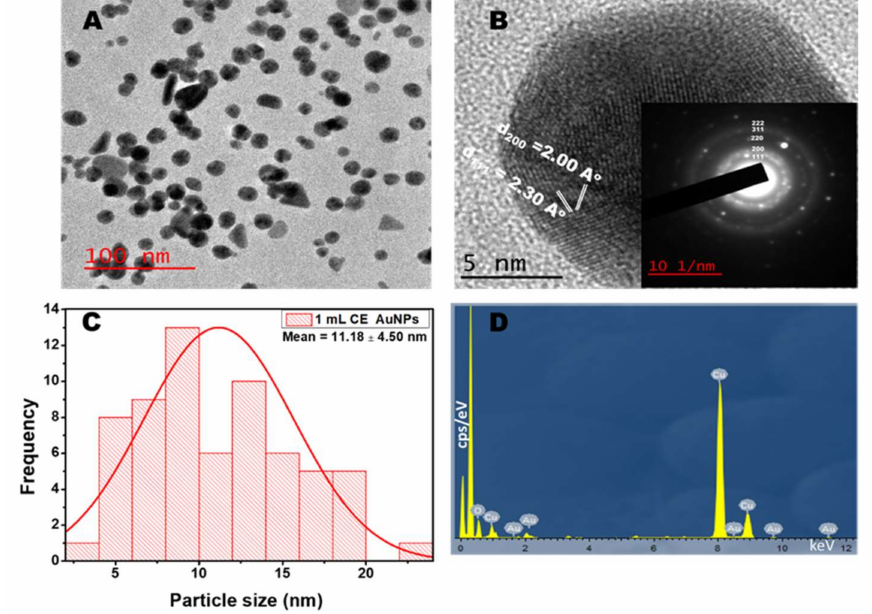
Figure 3. TEM ( A ) and HRTEM ( B ) images of Combretum erythrophyllum (CE) synthesised AuNPs inset: SAED ( C ) corresponding particle size distribution and ( D ) EDX spectra of AuNPs using 1 mL CE.